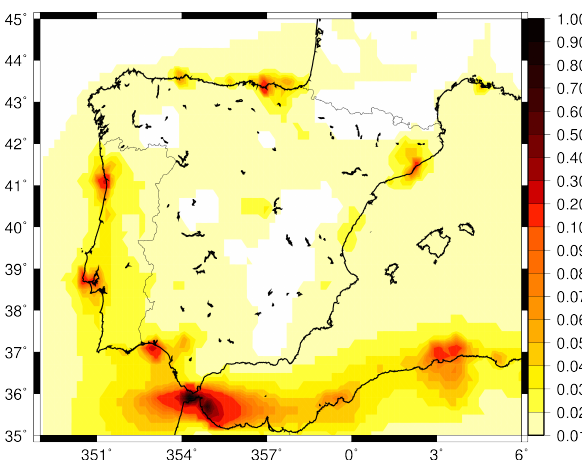
Fig. 18. Mean annual concentrations of lead (µgm − 3 ) for 2009 over Spain and Portugal.